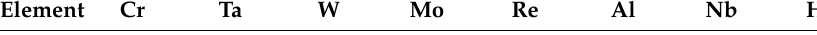
Table 1. Chemical composition of the DD6 single crystal alloy used in this study. Element Cr Ta W Mo